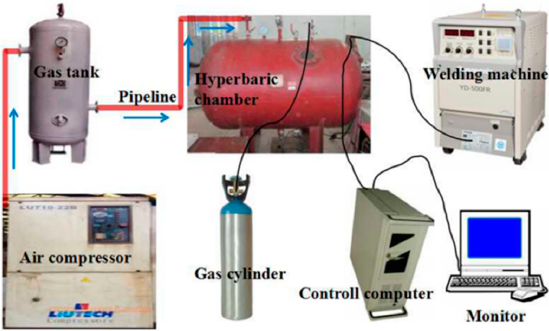
Figure 1. Schematic illustration of the underwater dry hyperbaric flux-cored arc welding (FCAW) system. The base metal (BM) is UNS S32101 DSS. The workpieces were prepared with a dimension of 300 mm × 100 mm × 10 mm (length × width × thickness). The filler material (FM) used was LINCOLN 1.2 mm. The chemical compositions of the BM and the FM are given in Table 1. Table 1. Chemical composition of base metal (BM) and filler metal (FM) (wt %).